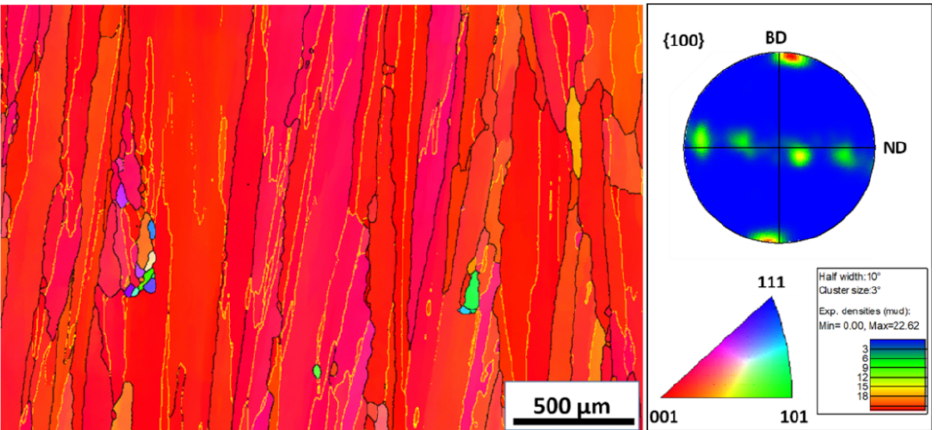
Figure 1. EBSD–IPF map of as-built EBM IN718 specimen with <001> orientation to the building direction. In the map, the low-angle grain boundaries (LABs) (2 ◦ ≤ θ < 10 ◦ ) and high-angle grain boundaries (HABs) (10 ◦ ≤ θ ) are indicated by yellow and black lines, respectively. (BD: Building Direction, ND: Normal Direction).